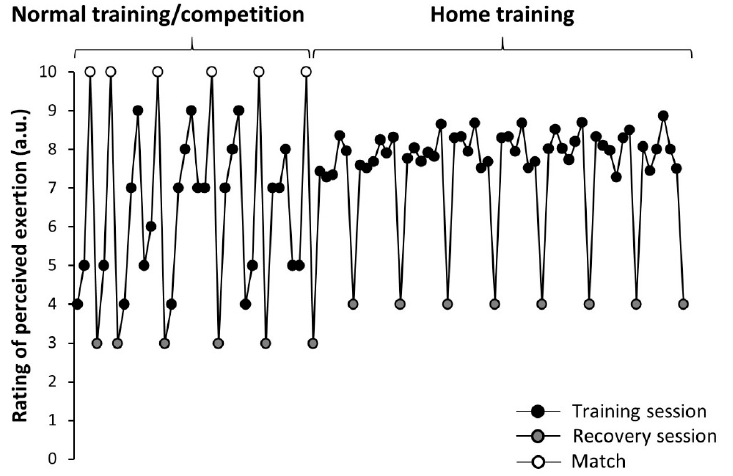
Figure 3. Distribution of injuries according to their type in professional football players before the suspension of LaLiga due to the COVID-19 pandemic and after the resumption of the competition. Figure 4 depicts RPE values obtained at the end of each training session in one team of LaLiga during 7 weeks prior to lockdown and for the 8 weeks that lasted during home confinement (home training). Each dot represents the mean value for all the players who took part in the training session/match. During the normal training/competition period, the team played one match per week, except for the first week. As is shown in Figure 4, players perceived exertion was variable during the period of normal training and competition, with values of 10 a.u. of RPE in the days with a match and values of 3 a.u. of RPE in the day after the match that corresponded to a recovery session. On the other hand, RPE values were more stable during home confinement (between 7 and 8 a.u.), as the load was similar for each day and there was no need to reduce training load to prepare for a match. However, the strength and conditioning staff of this team prescribed a training day per week during home confinement with a lower load (including light aerobic exercise and stretching routines), and the RPE value for these days was 4 a.u.